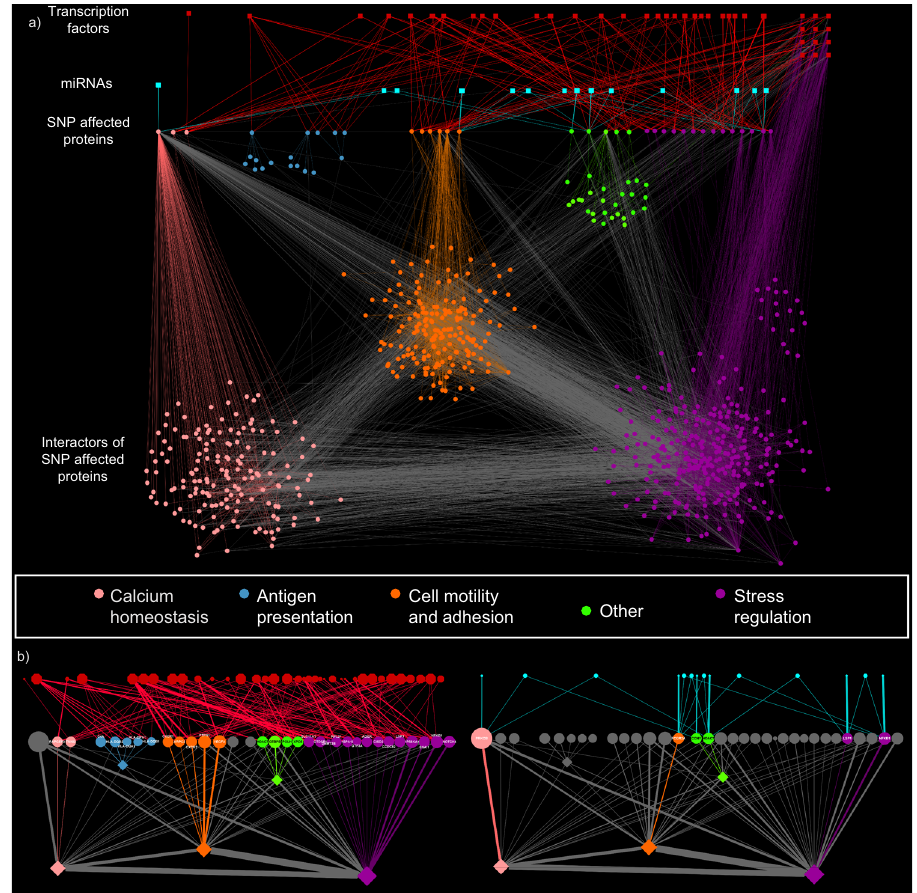
Fig. 2 Visualisation and modularisation of the ulcerative colitis-associated signalling network. a The ulcerative colitis (UC)-associated signalling network contains proteins affected by — associated single nucleotide polymorphisms (SNPs), their interactor partners as well as the transcription factors(TF) and micro-RNAs(miRNA) whose binding or target sites are affected by a SNP. Circles represent proteins and squares represent regulators (red = TFs, blue = miRNAs). Nodes are coloured according to network modules. The modules are named by their representative function. At the top right side of the network are TFs involved in potential regulatory feedback loops in UC pathogenesis. b Visualisation of the two regulatory modules. The module on the left represents the transcription factor binding sites based effects on the downstream network, which affects almost the entire signalling network. The module on the right represents the microRNA-target site based effects that mainly happen by regulating PRKCB